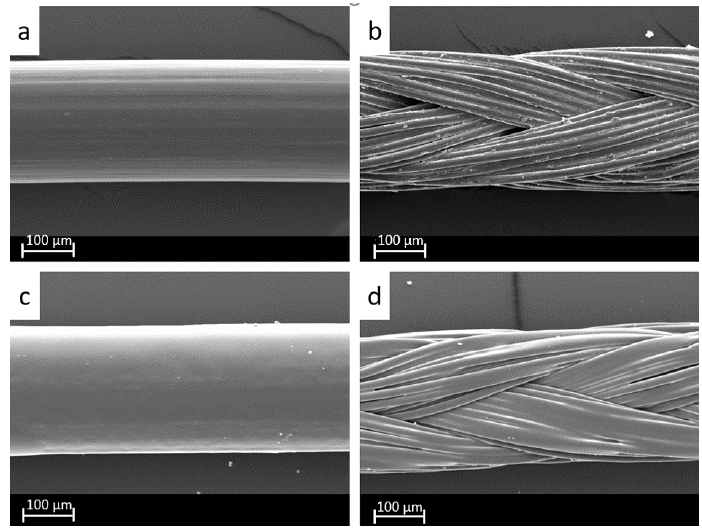
Figure 2. SEM investigation of ( a ) uncoated monofilament and ( b ) uncoated multifilament sutures as well as ( c ) totarol-poly(lactide-co-glycolide acid) (PLGA) (ratio 1:1) coated monofilament and ( d ) totarol-PLGA (ratio 1:1) coated multifilament sutures at 400× magnification.